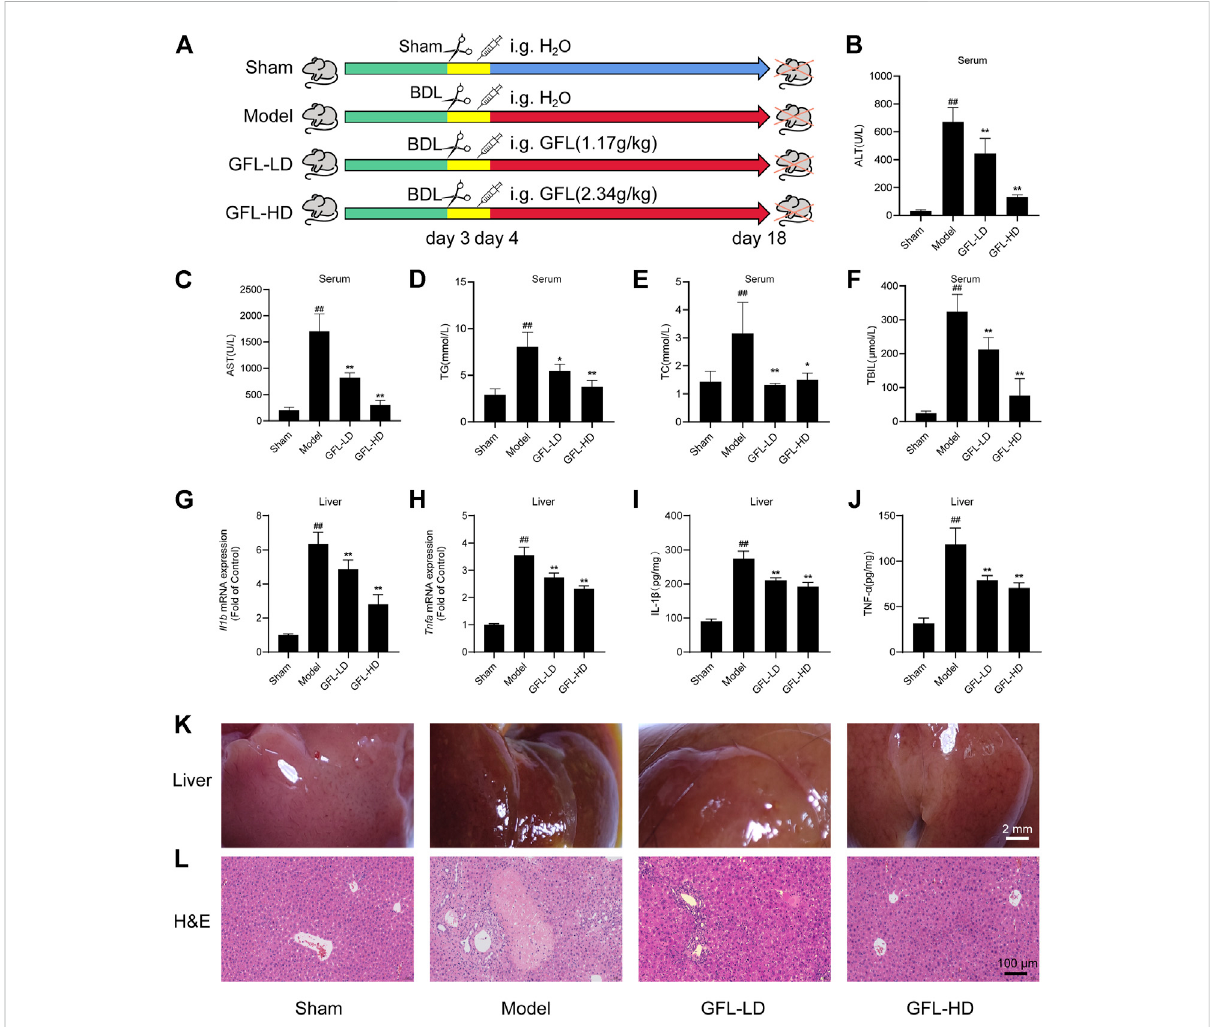
FIGURE 2 Effect of GFL on liver injury and in fl ammation in mice. (A) C57BL/6 mice were divided into sham (sham operation), model (bile duct ligation), GFL-LD (1.17 g/kg), and GFL-HD (2.34 g/kg) groups. In the sham group, the bile duct was separated but not ligated. In the model, GFL-LD, and GFL- HD groups, the bile duct was ligated. GFL-LD and GFL-HD groups were treated with different concentrations of GFL for 2 weeks 24 h after bile duct ligation. The Sham and model groups were given equal volume of normal saline. Contents of (B) AST, (C) ALT, (D) TG, (E) TC, and (F) TBIL in serum. mRNA expression of (G) IL-1 β and (H) TNF- α in the liver. Protein expression of (I) IL-1 β and (J) TNF- α in the liver. (K) Super fi cial view of liver tissue (×4 magni fi cation). (L) Representative H&E staining images of liver tissue sections (×200 magni fi